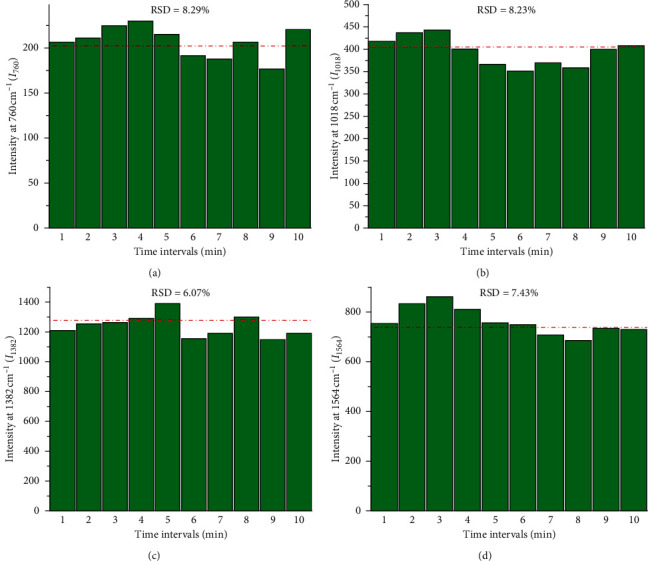
RSD of (a) I760, (b) I1018, (c) I1382, and (d) I1564 of NAP randomly collected at time intervals of 1 min.